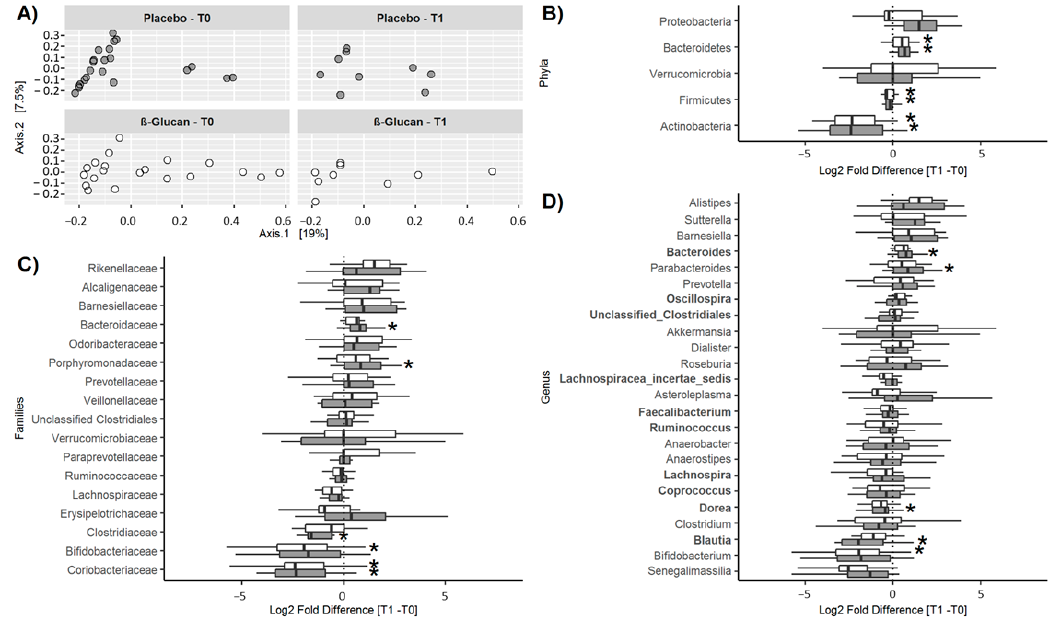
Figure 4. ß-diversity and changes in relative abundances (Log2 fold differences) of bacterial taxa between T1 and T0. ( A ) Inter-individual β -diversity at T0 (before treatment) and T1 (after treatment) in the control and β -glucan groups. Changes in the relative abundances of bacterial phyla ( B ), families ( C ), and genera ( D ). In Figures B – D , only bacterial taxa with a prevalence >50% are shown. In the box and whisker plots, the line shows the median, the wide of the box, the interquartile range and the whiskers, the highest and lowest values. * p < 0.05.